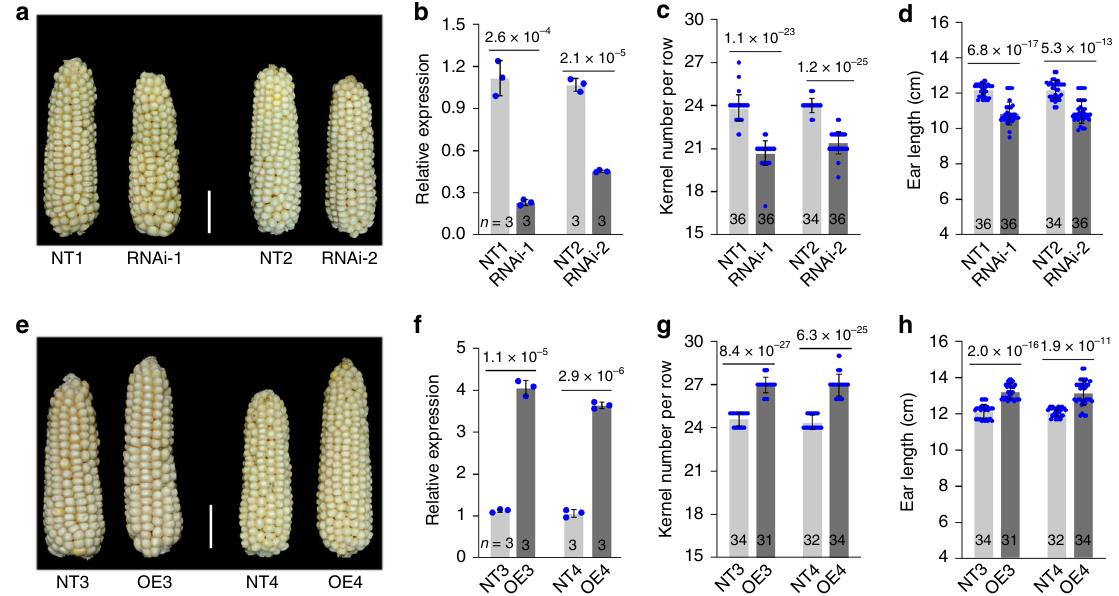
Fig. 2 Function of KNR6 on kernel number per row and ear length. a KNR6 RNAi transgenic lines (RNAi-1 and RNAi-2) have shorter ears than do non- transgenic sib lines (NTs). b , f KNR6 expression in two RNAi lines ( b ) and two KNR6 -overexpressing lines ( f ). Gene expression level is analyzed using quantitative PCR with three biological replicates, and each with three technical replicates. The maize Actin gene ( Zm00001d010159 ) is used as an internal control. p Value is estimated using the two-tailed Student ’ s t test. c , d Phenotypes of KNR ( c ) and EL ( d ) in two RNAi lines. e KNR6 -overexpressing lines (OE3 and OE4) have longer ears than do non-transgenic sib lines (NTs). g , h Phenotypes of KNR ( g ) and EL ( h ) in two KNR6 -overexpressing lines. The values in ( c , d , g , h ) are means ± s.d. Number on the bottom of each column is the sample size. Signi fi cance is estimated by the one-way ANOVA. Scale bar = 3 cm in ( a ) and ( e ). Source data underlying Fig. 2c, d are provided in a Source Data fi